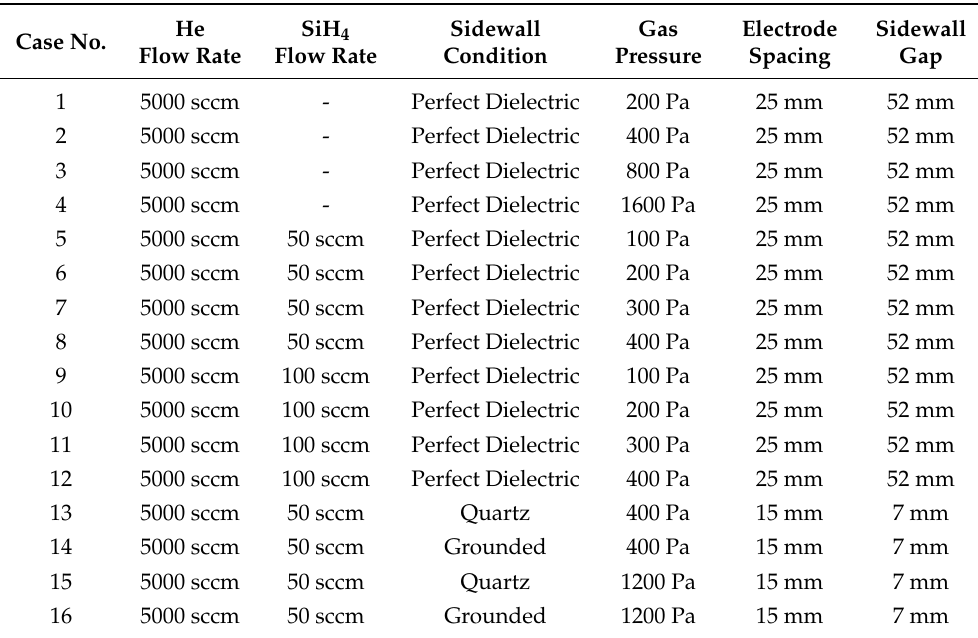
Table 1. List of cases considered in this study. Case